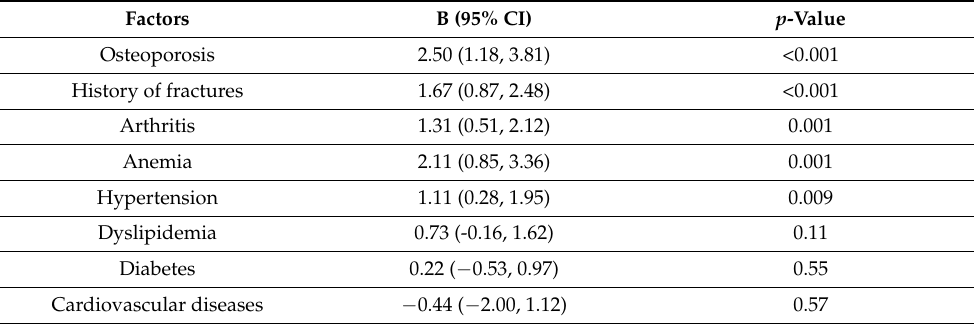
Table 3. Multiple linear regression for the severity of low back pain and the associated risk